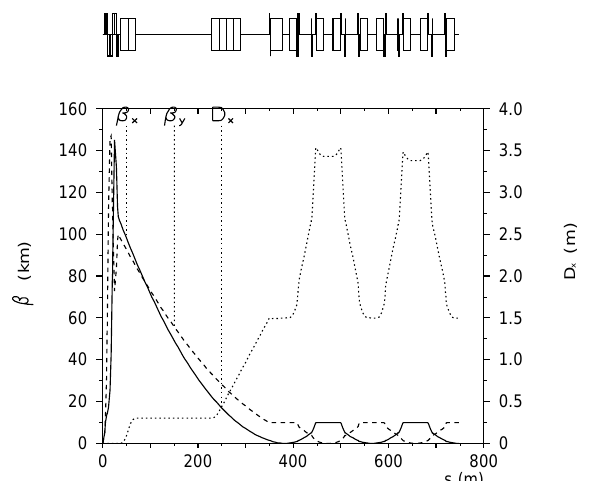
FIG. 41. Example (a): 3 TeV IR and chromatic correction sec- tion.